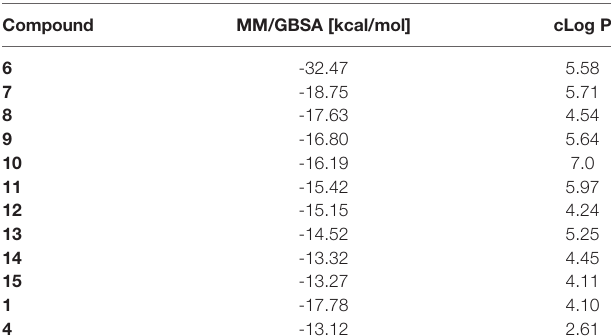
TABLE 1 | In silico screening results: Average binding energies were calculated over a molecular dynamics trajectory using MM/GBSA method; cLog P values were determined in MOE using an empirical method based on single atom